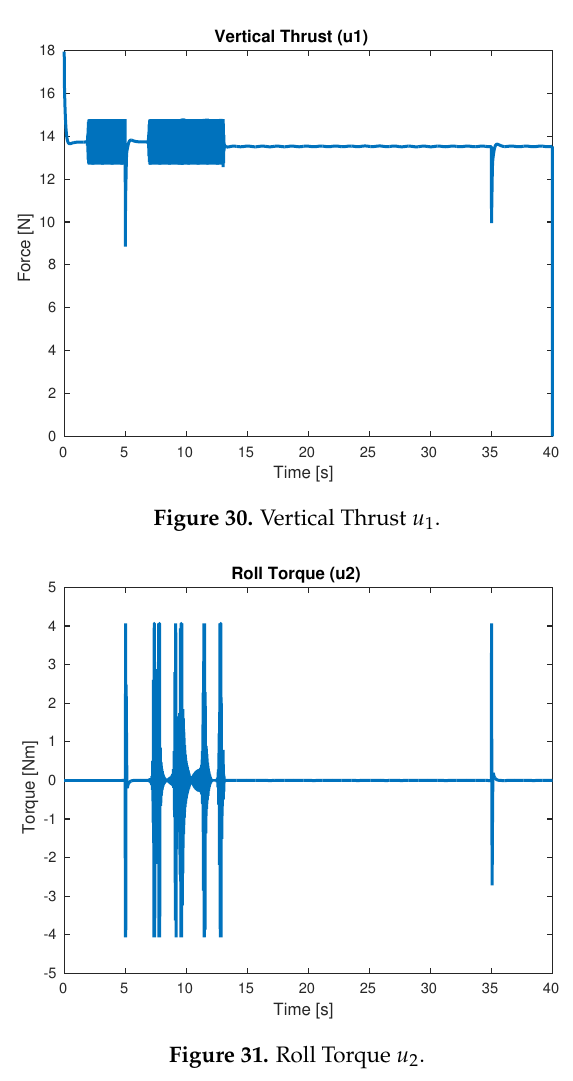
Figure 31. Roll Torque u 2